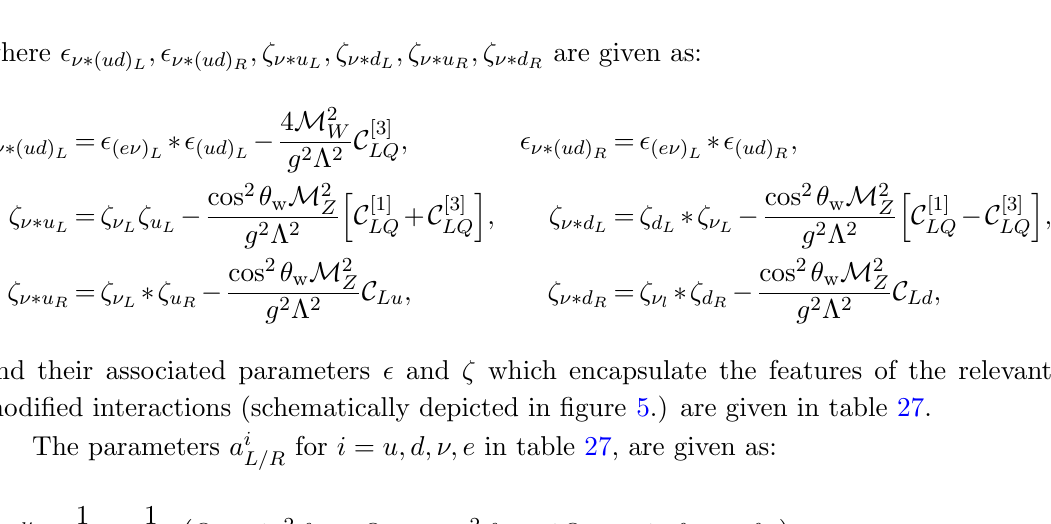
Figure 5. The e(cid:11)ective interactions among gauge bosons with the fermions. The [ the modi(cid:12)ed Feynman vertex (renormalizable + corrections due to dimension-6 operators) factors which are tabulated in the following sections for both 2HDM and MLRSM e(cid:11)ective